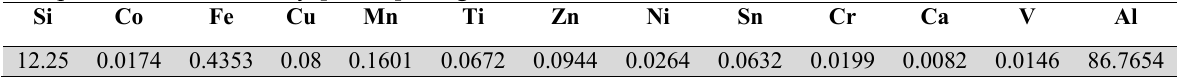
Composition of Al-Si alloy [wt. %] designated as matrix Si Co Fe